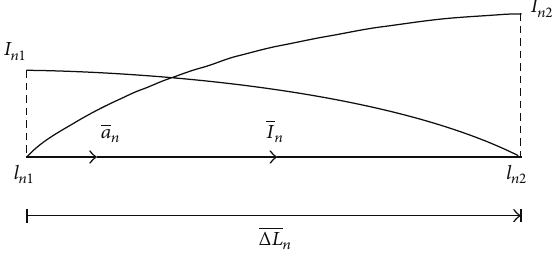
Figure 2: Sinusoidal current element in one